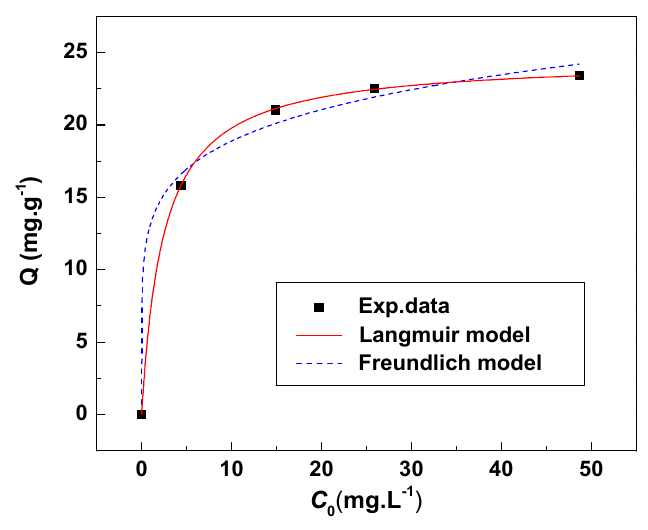
Table 4. Dynamic parameters of lithium adsorption.